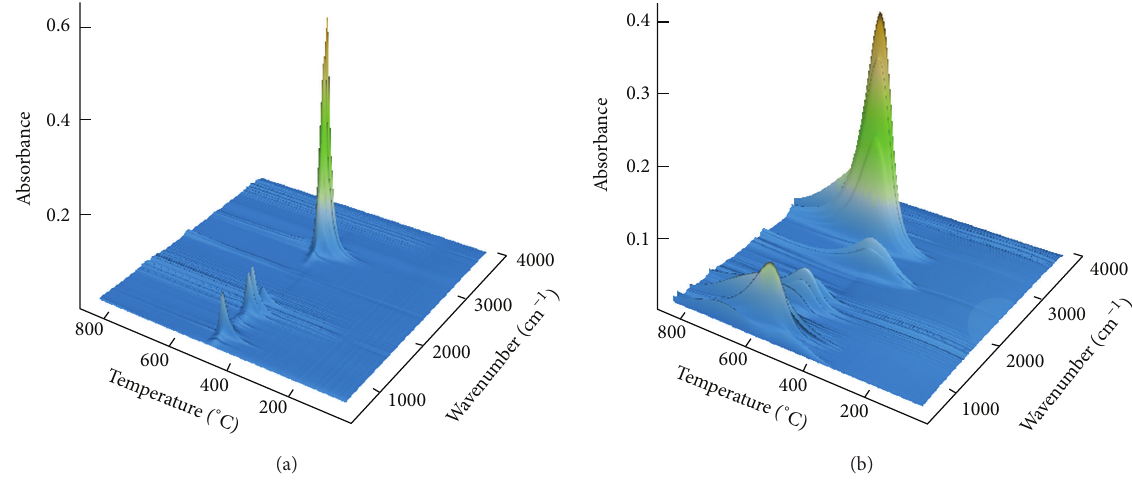
Figure 8: 3D TG-FTIR spectra of pyrolysis gases of (a) PP and (b) PP-6 during the thermal